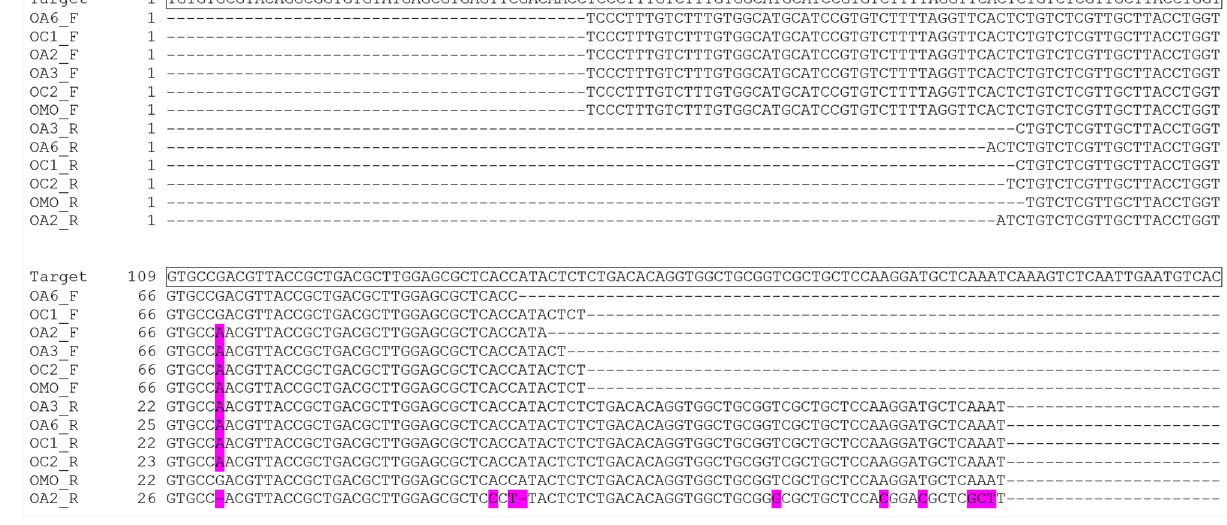
Figure 5. Sequence comparison of the shortest LAMP-product to the target region. The forward and reverse reads obtained from six randomly selected T. controversa samples aligned to the target region. The alignment is illustrated using BOXSHADE and non-matching nucleotides to the target region are highlighted in